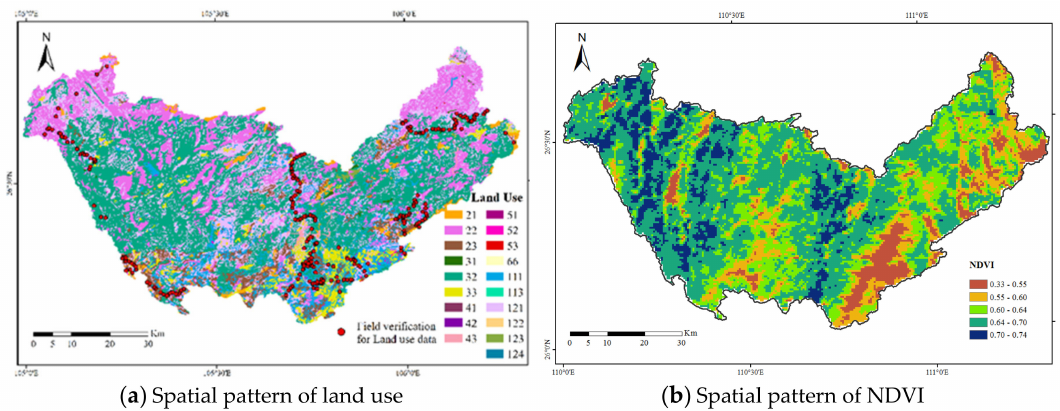
Figure 2. Spatial patterns of land use ( a ) and vegetation activity ( b ) in the study area. Land use types are: 21 = orchard, 22 = tea garden, 23 = other garden, 31 = forest land, 32 = shrubland, 33 = other forest land, 41 = natural grassland, 42 = tame pasture, 43 = other grassland, 51 = wholesale and retail land, 52 = accommodation and catering land, 53 = commercial and financial land, 61 = industrial land, 62 = mining land, 63 = warehouse land, 66 = other lands, 111 = river surface, 113 = reservoir surface, 121 = vacant land, 122 = facility agricultural land, 123 = ridge , and 124 = saline-alkali land